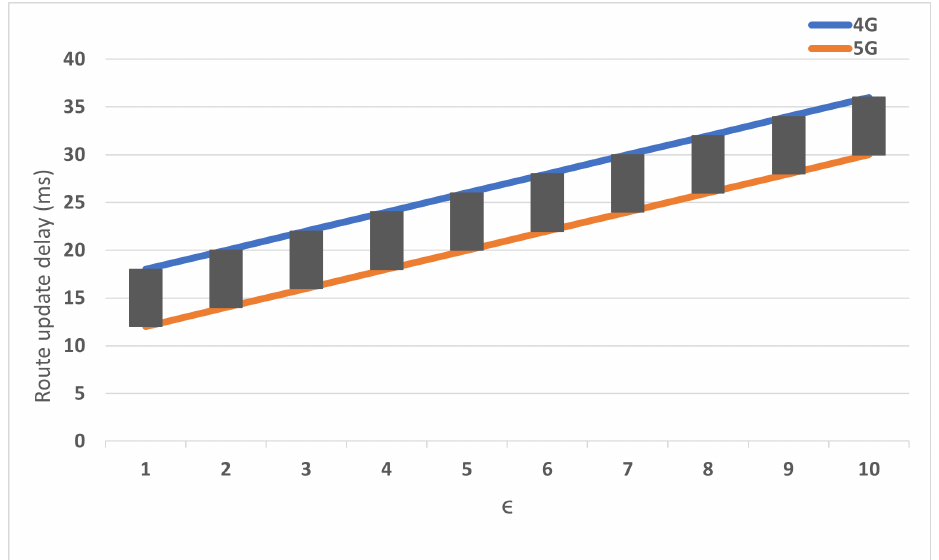
Figure 13. The impact of (cid:101) on the handover